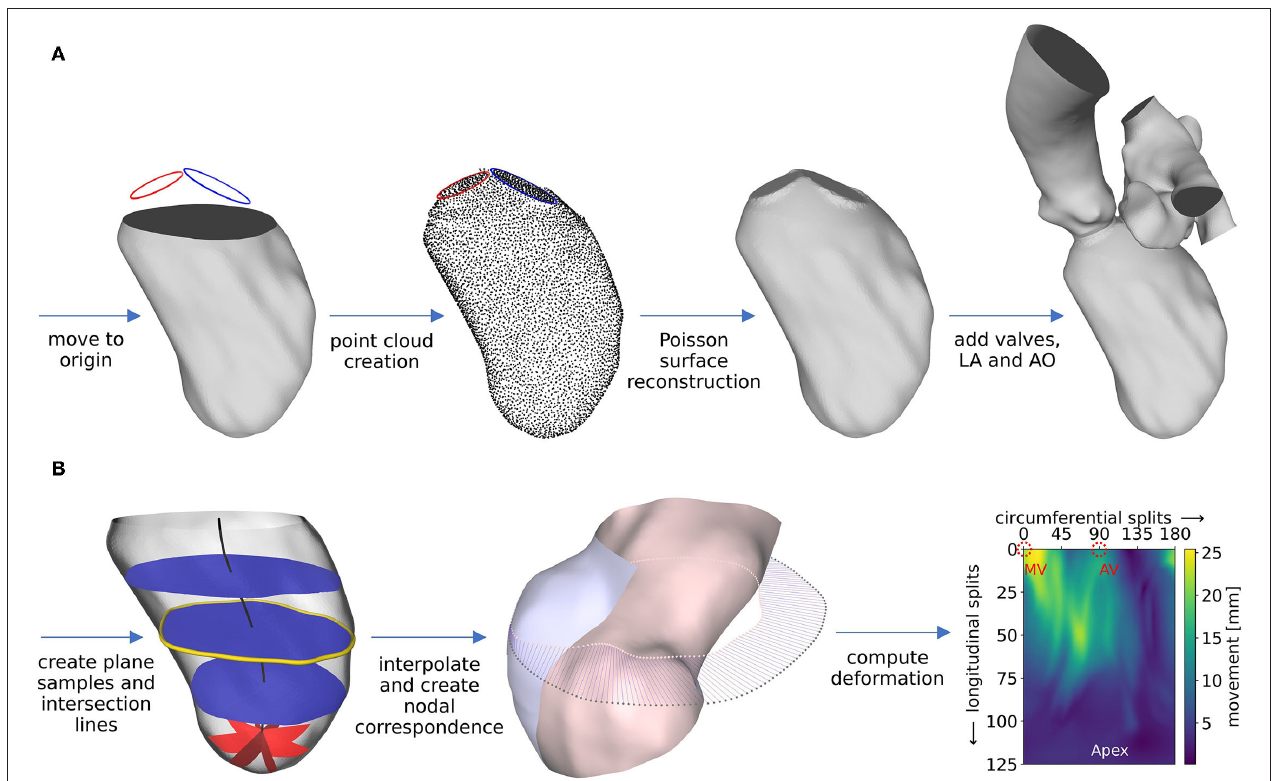
FIGURE 4 | Schematic workflow representation for pre-processing of geometry (A) and motion (B) , exemplified for case M0A1. Details about the workflow are described in the